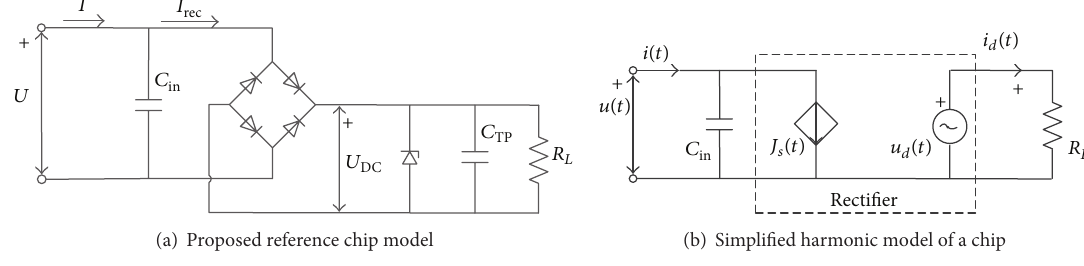
Figure 6: Proposed reference model and simplified harmonic model of a chip.